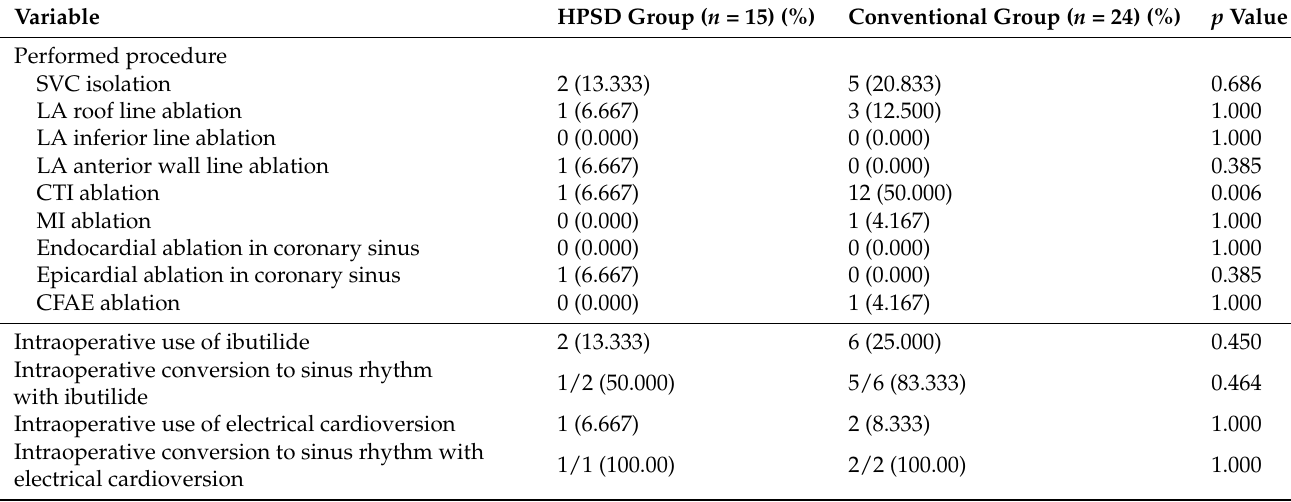
Table 6. First procedure characteristics of patients undergoing repeat procedures.